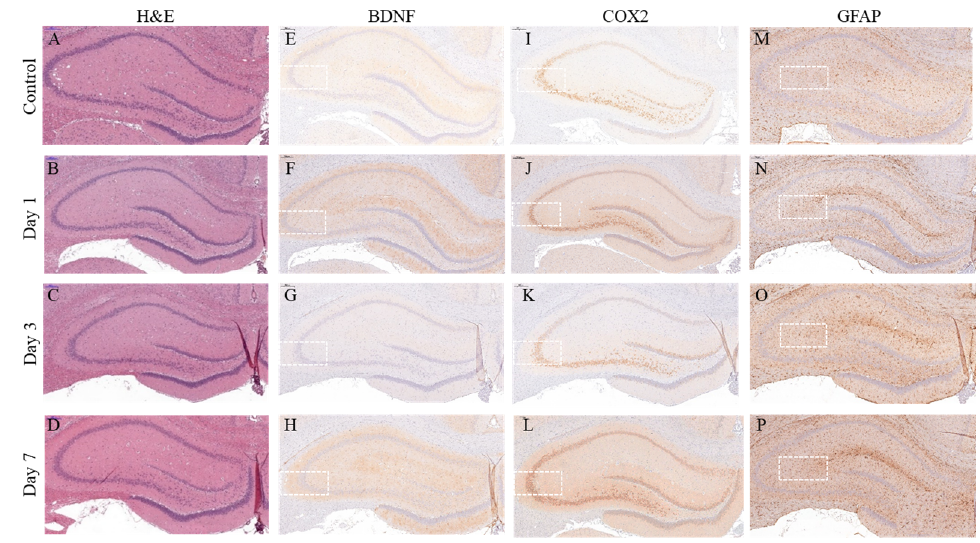
Figure 2. Acute severe stress led to changes in the expression patterns of neuroinflammation markers in the hippocampus. Representative hematoxylin and eosin (H&E) staining images of the hippocampus: ( A ) Control; ( B ) Day 1; ( C ) Day 3; and ( D ) Day 7. Images of immunohistochemical (IHC) staining of brain-derived neurotrophic factor (BDNF) in the hippocampus: ( E ) Control; ( F ) Day 1; ( G ) Day 3; and ( H ) Day 7. Images of IHC staining of cyclooxygenase-2 (COX2) in the hippo- campus: ( I ) Control; ( J ) Day 1; ( K ) Day 3; and ( L ) Day 7. Images of IHC staining of glial fibrillary acidic protein (GFAP) in the hippocampus: ( M ) Control; ( N ) Day 1; ( O ) Day 3; and ( P ) Day 7.